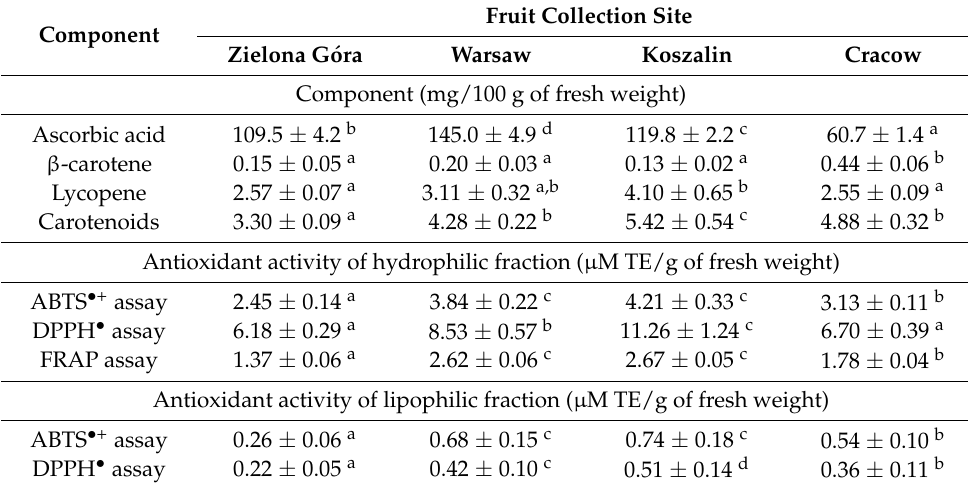
Table 1. Bioactive components and antioxidative potential of red arils (mean ± SD). Fruit Collection Site Component Zielona G ó